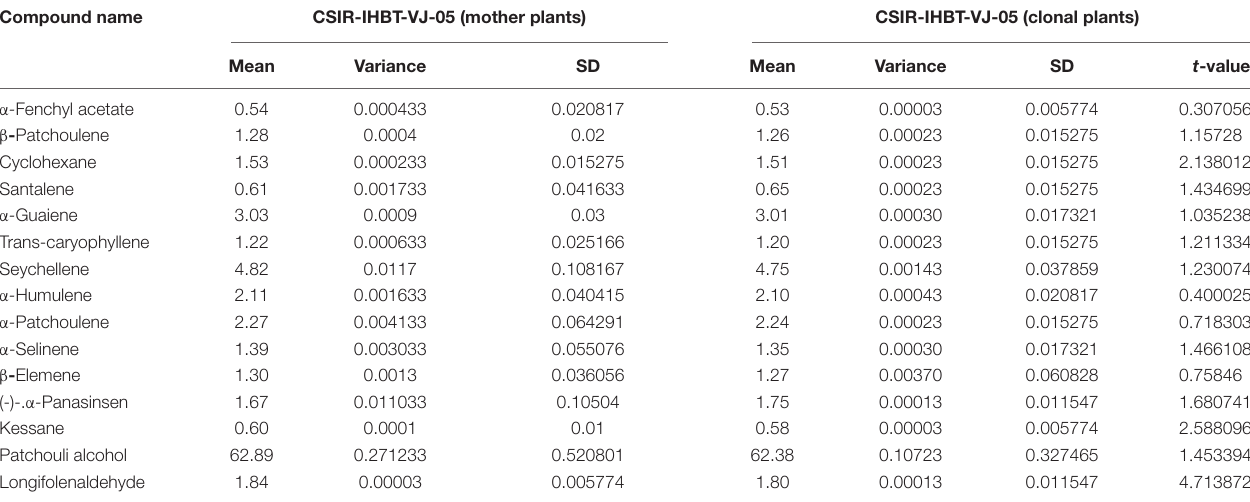
TABLE 5 | Variations of essential oil compounds in mother plant and vegetatively propagated clone of CSIR-IHBT-VJ-05.